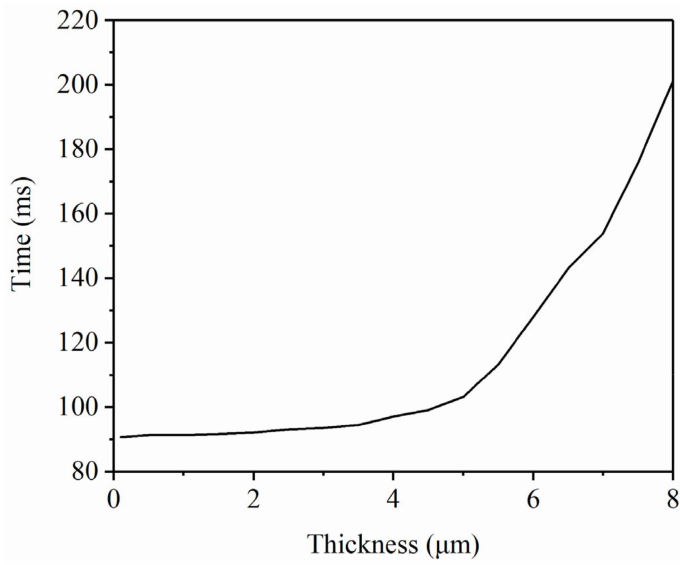
Figure 6. Relationship between thickness and response